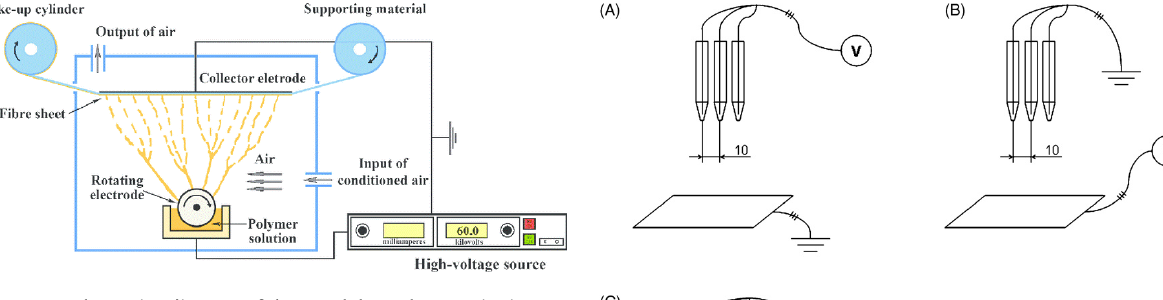
Figure 8: Schematics diagram of the nozzleless electrospinning setup [© 2016 Sasithorn N, Martinová L, Horáková J, Mongkholrat- tanasit R] [49].